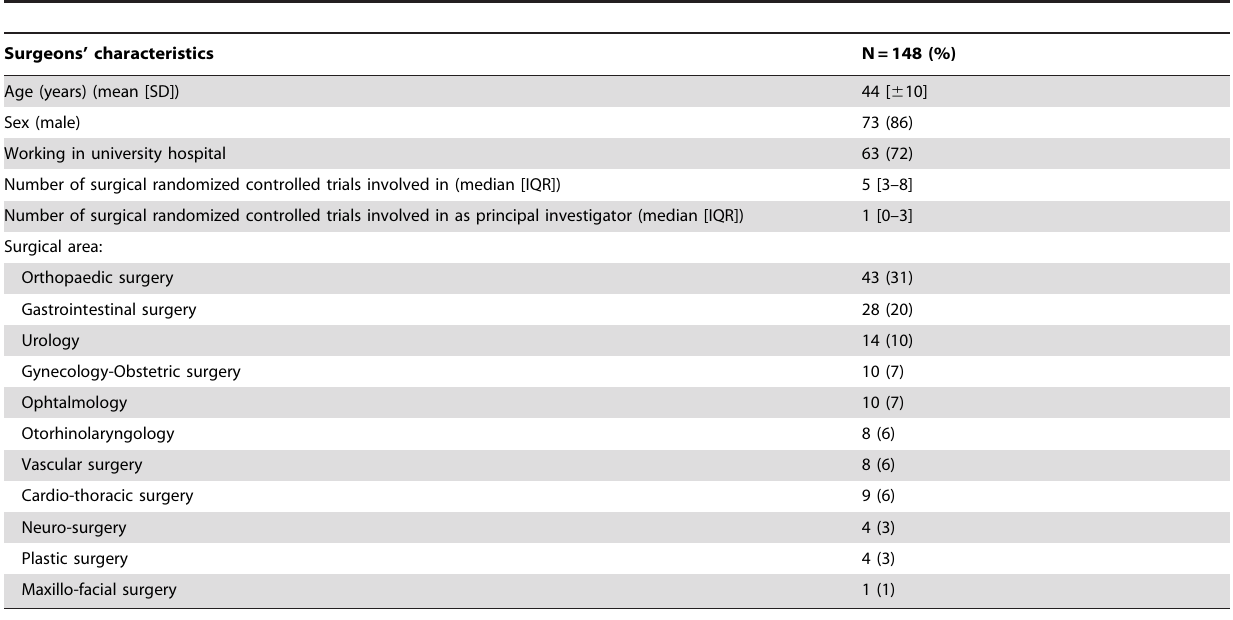
Table 1. The general characteristics of surgeons completing the web survey (N=148).